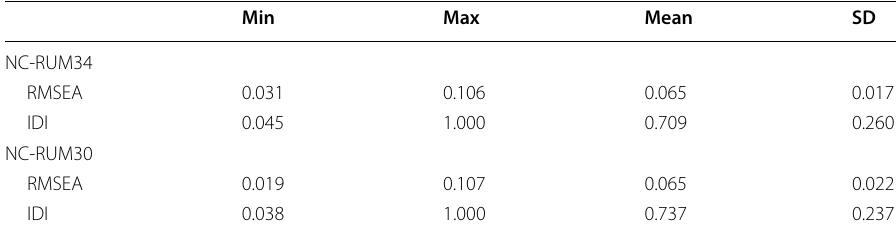
Table 6 Item-level fit measures